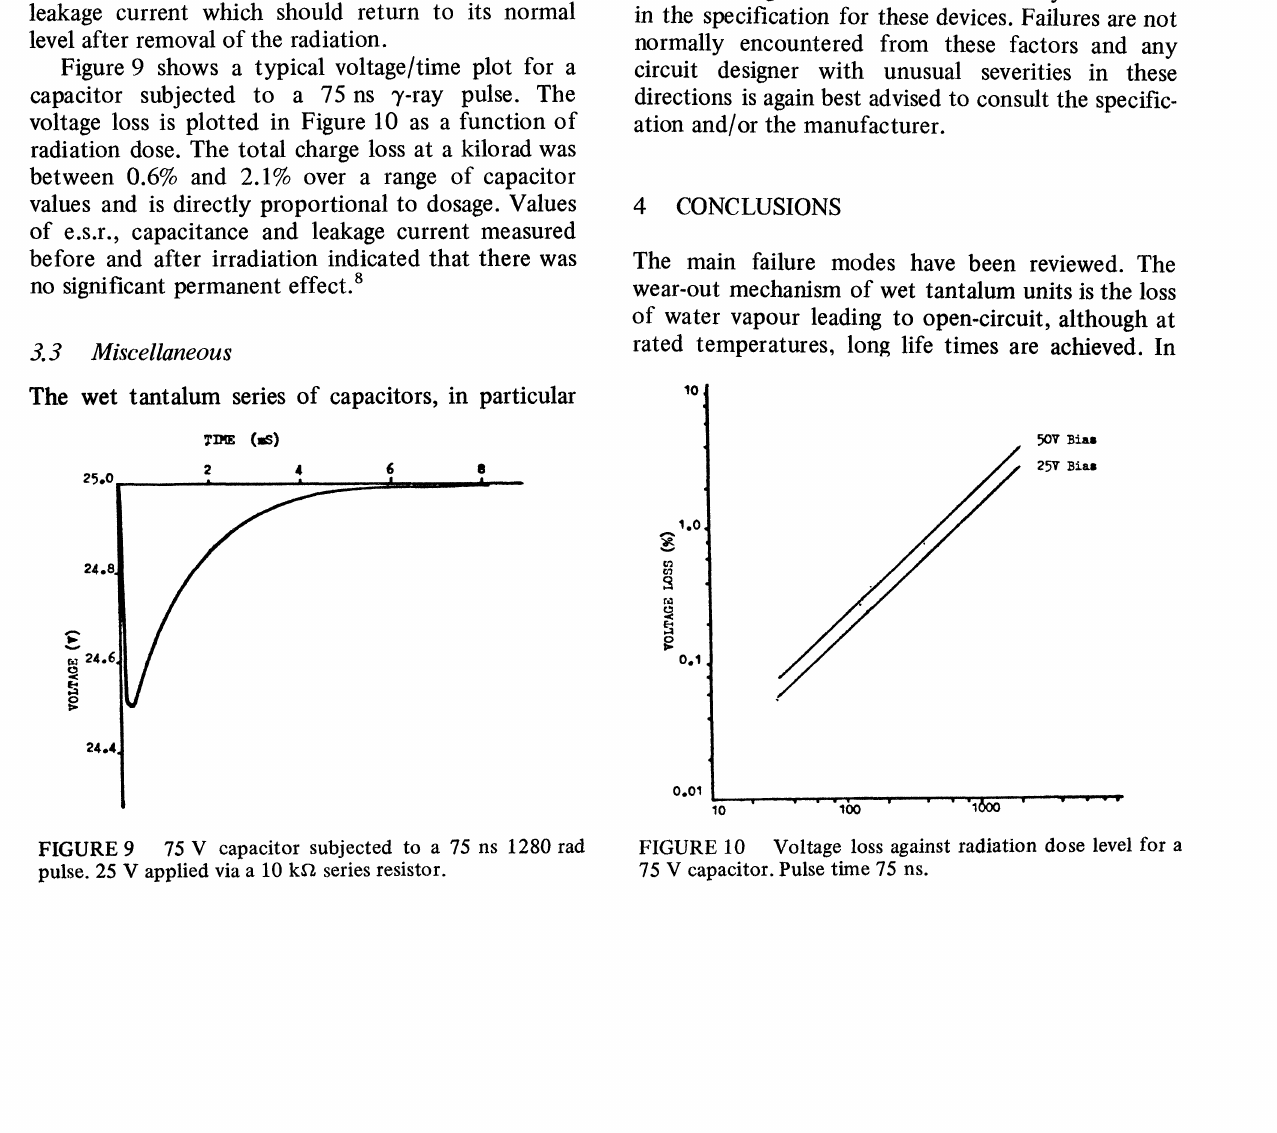
Voltage loss against radiation dose level for a 75 V capacitor. Pulse time 75